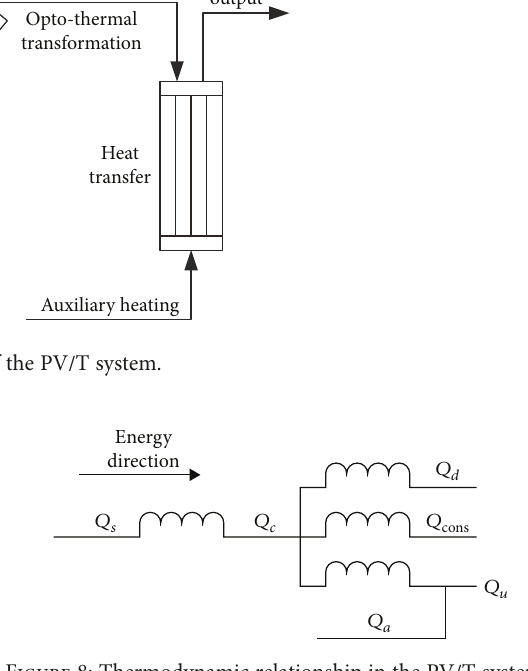
Figure 8: Thermodynamic relationship in the PV/T